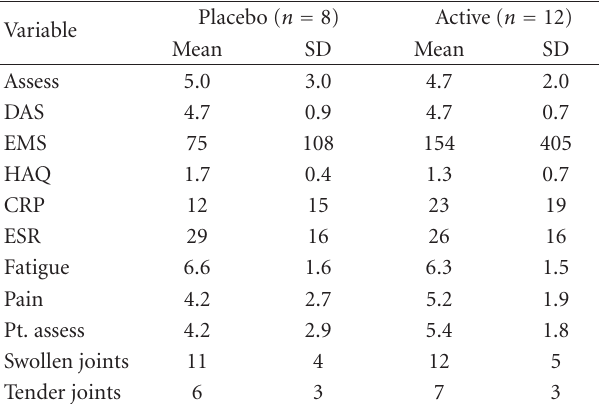
Table 2: Baseline characteristics of each